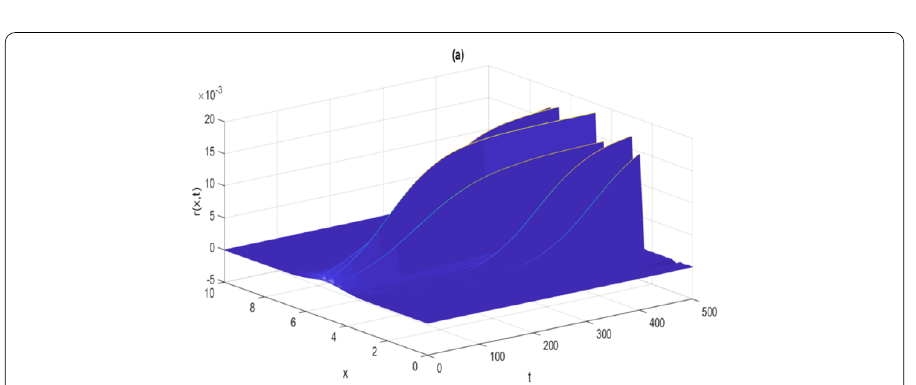
Figure 4 The approximation solution of the fractional order differential equation